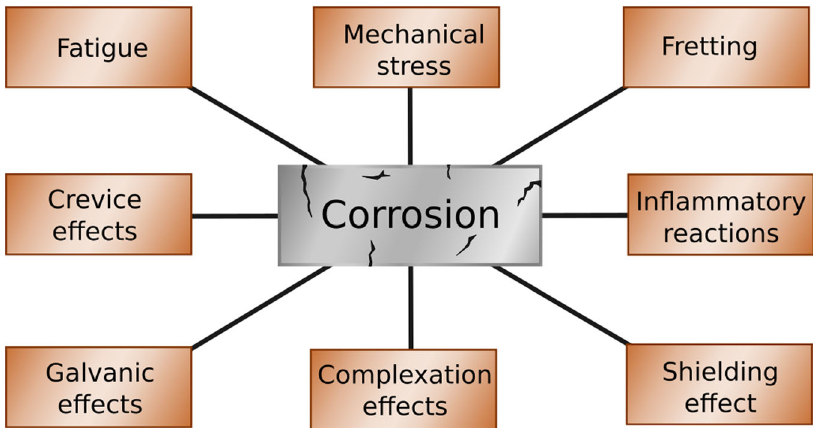
Fig. 2 Damage to the protective surface fi lm on titanium. Most common effects that enhance the degradation of materials in the human